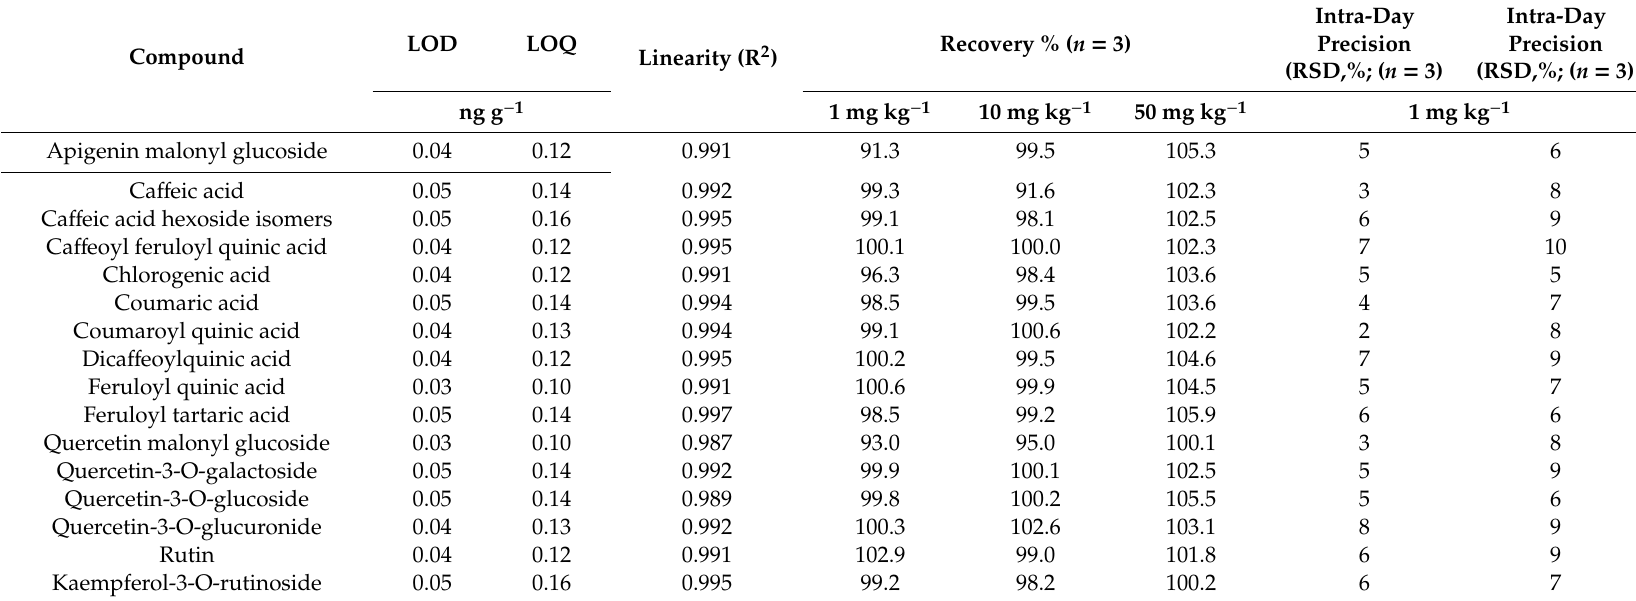
Table 3. Linearity, LOD, LOQ, precision and recovery for the 16 authentic standards ( n =